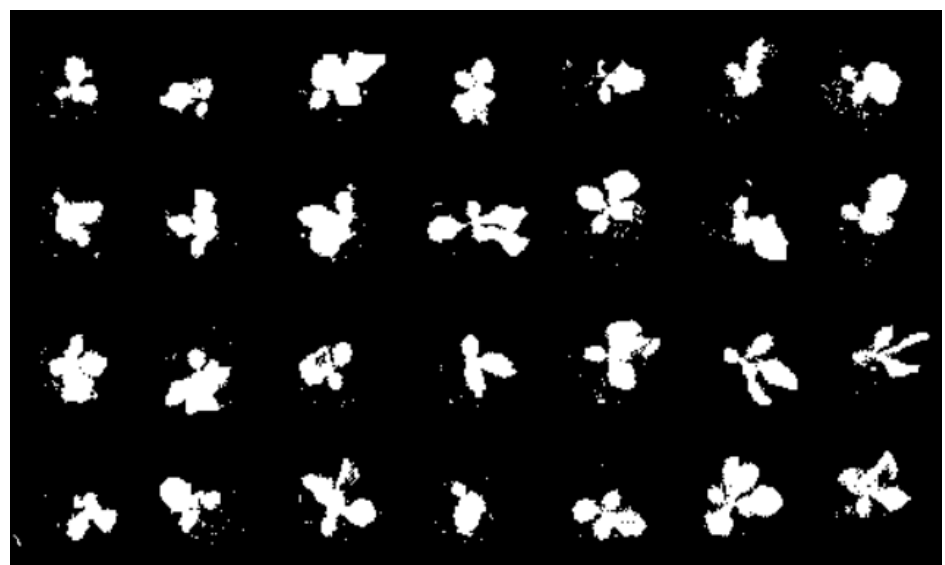
Figure 5. Binary image of lettuce plug seedling with seedling age of 17 d.